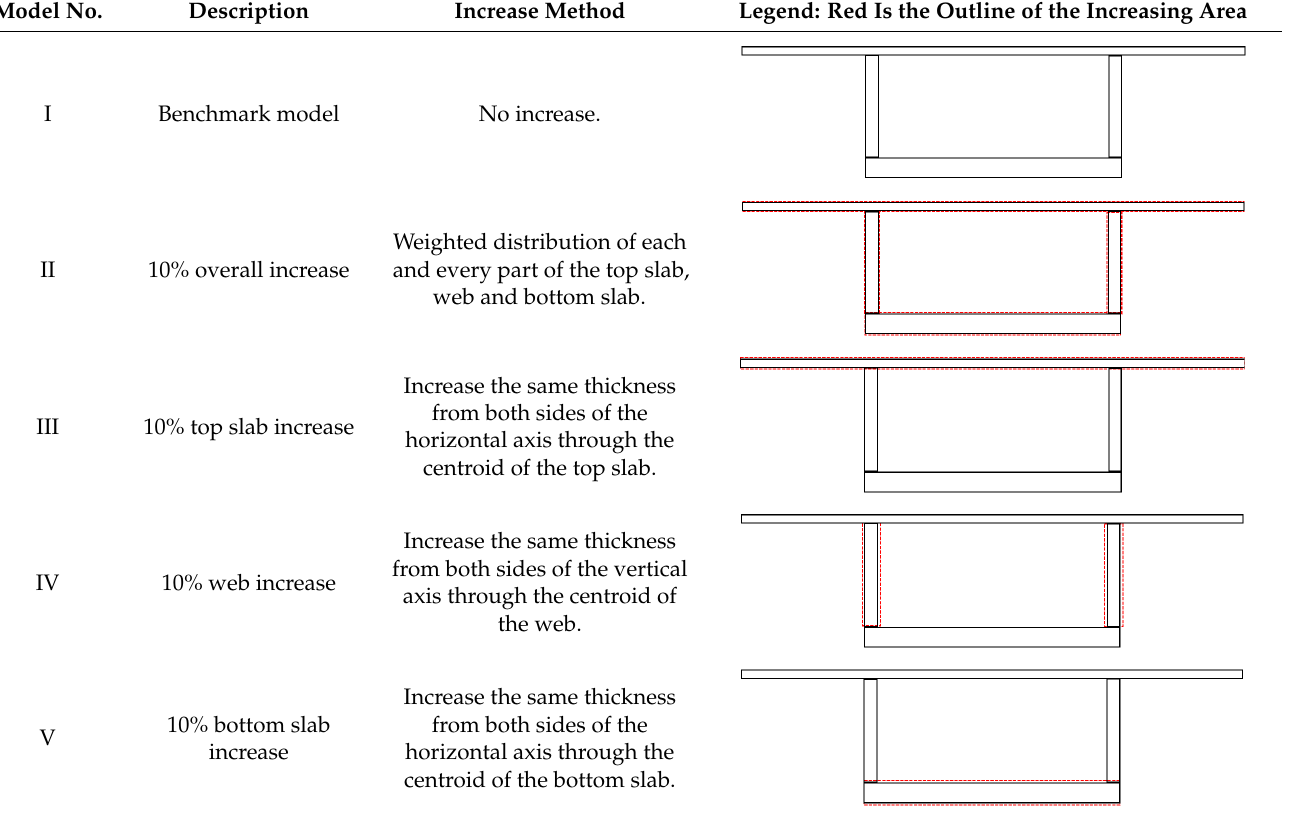
Figure 5. Element mesh in the cross-section.